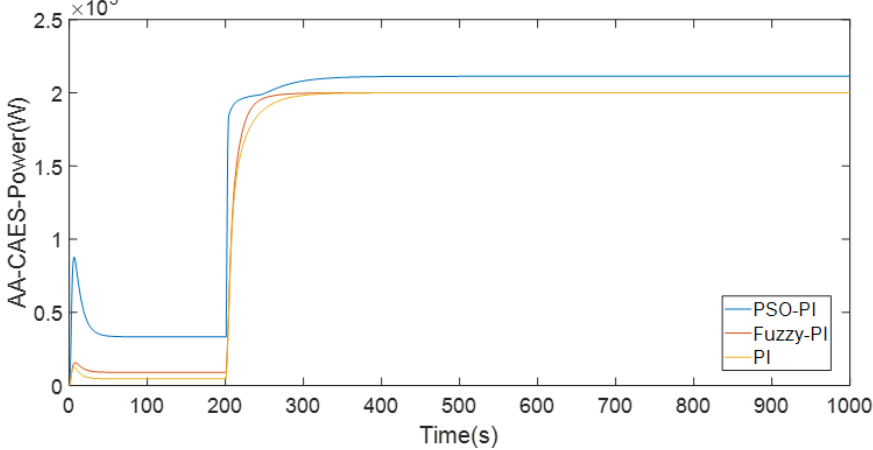
Figure 38. Output power of AA-CAES when one generator fails.